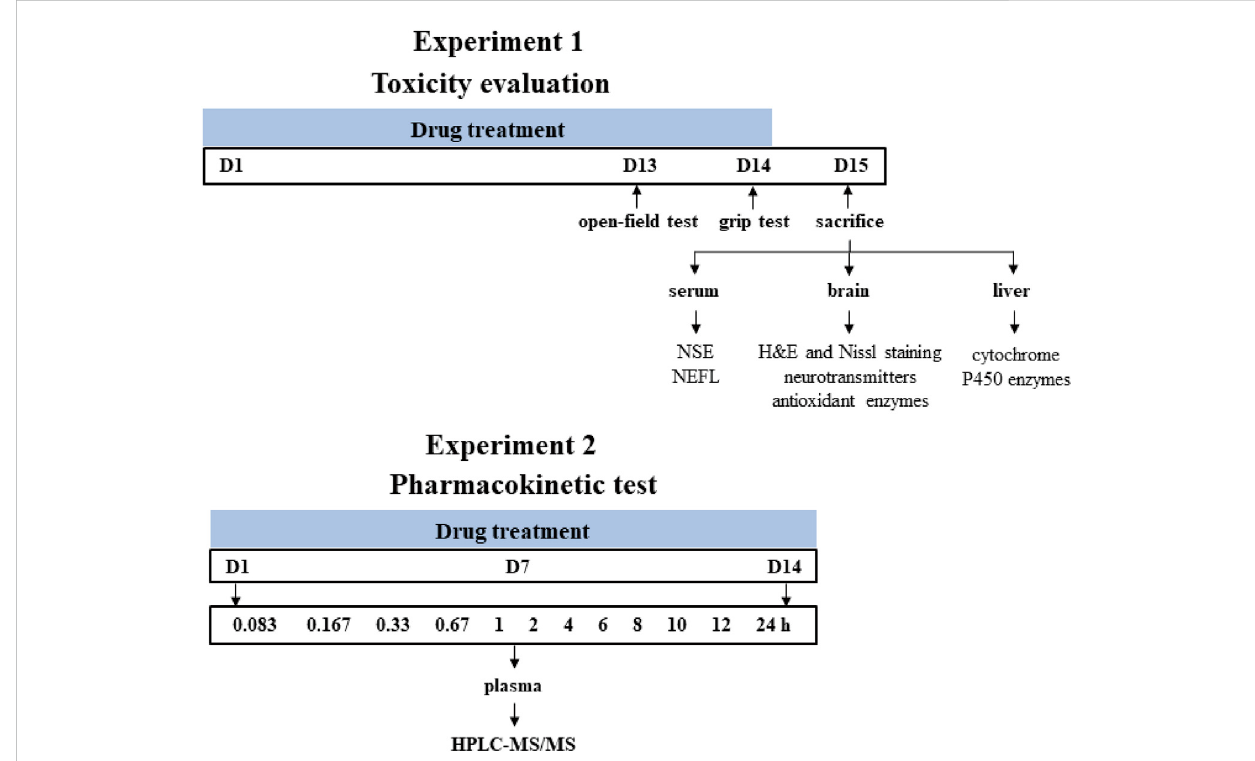
FIGURE 1 Schematic diagram of the experiment design. Time points represent the days of drug